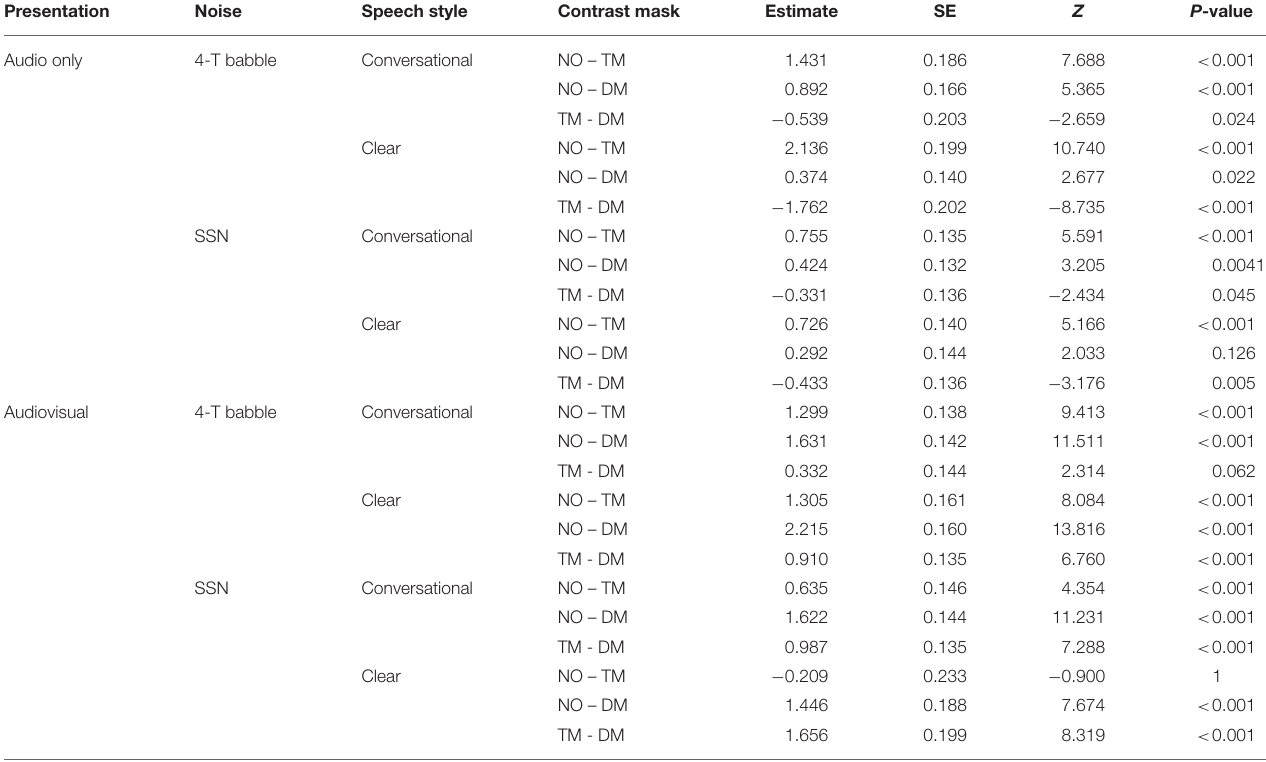
TABLE 4 | The contrast of face masks (no mask, NO, transparent mask, TM, and disposable face mask, DM) in each speaking style, background noise, and presentation mode. Presentation